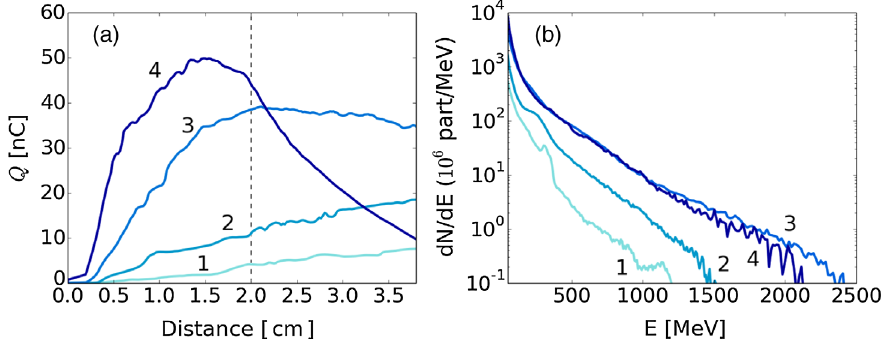
FIG. 2. Accumulation of electron charge and generation of thermal energy distributions in the SM-LWFA. (a) Electron charge Q in the energy range above 70 MeVas a function of the propagation distance. (b) Electron energy distribution after 2 cm of propagation. From 2 . 8 × 10 17 cm − 3 , (2) n 5 . 6 × 10 17 cm − 3 , (3) n 1 . 1 × 10 18 cm − 3 and (4) n 2 . 8 × 10 18 cm − 3 lighter to darker blue: (1) n e ¼ e ¼ e ¼ e ¼